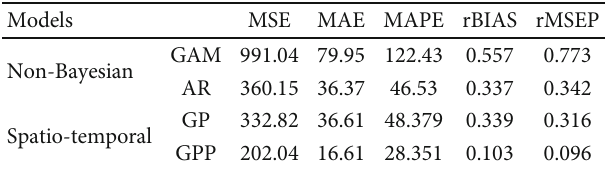
Table 4: Validation statistics for the GP, AR, and GAM models.